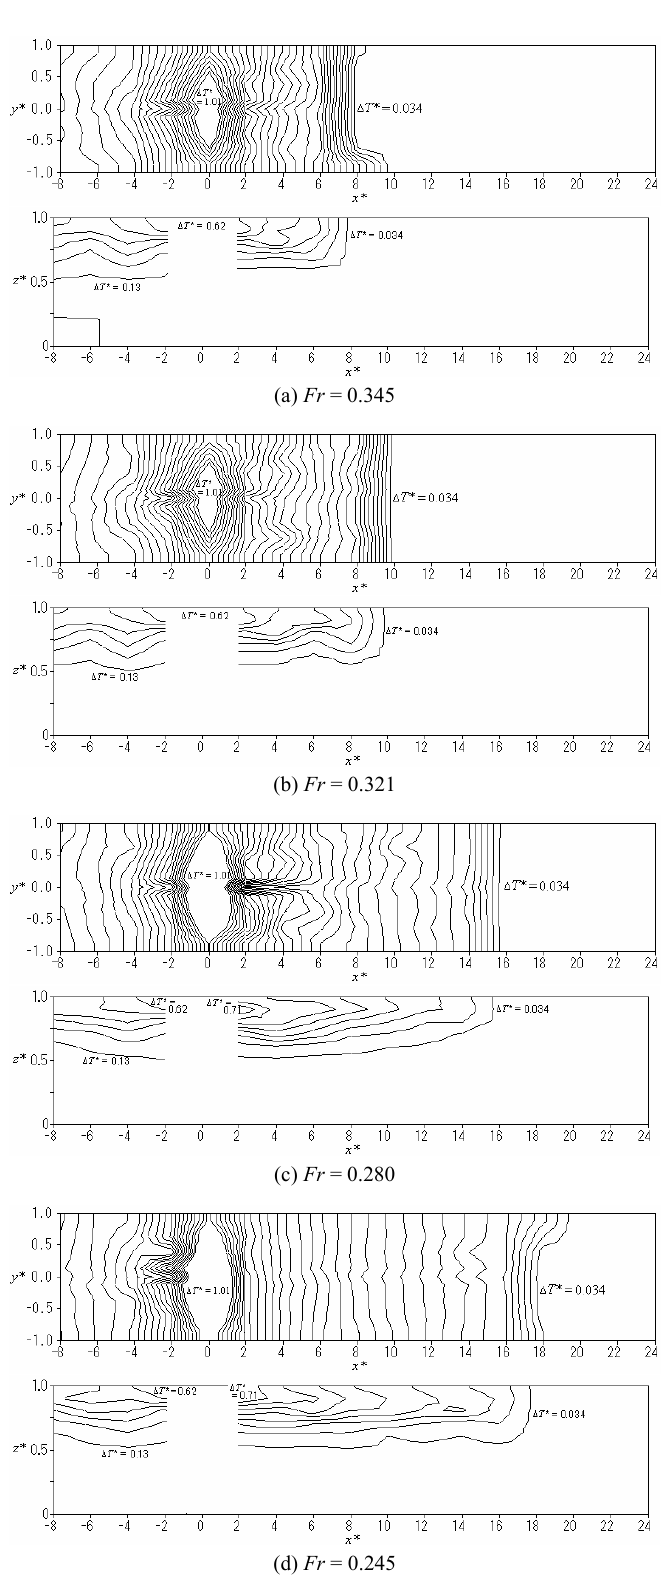
Fig. 7 Contour maps for four different Froude numbers in the case of the average dimensionless quasi-steady heat release rate Q * m at 0.0775. The temperature at the ceiling and longitudinal section is divided into 30 and 10 levels, respectively. When the ambient temperature T 0 is 298 K, the dimensionless temperature T * = 0.034 and 1.01 corresponds to the temperature rise δ T = 10 and 300 K,